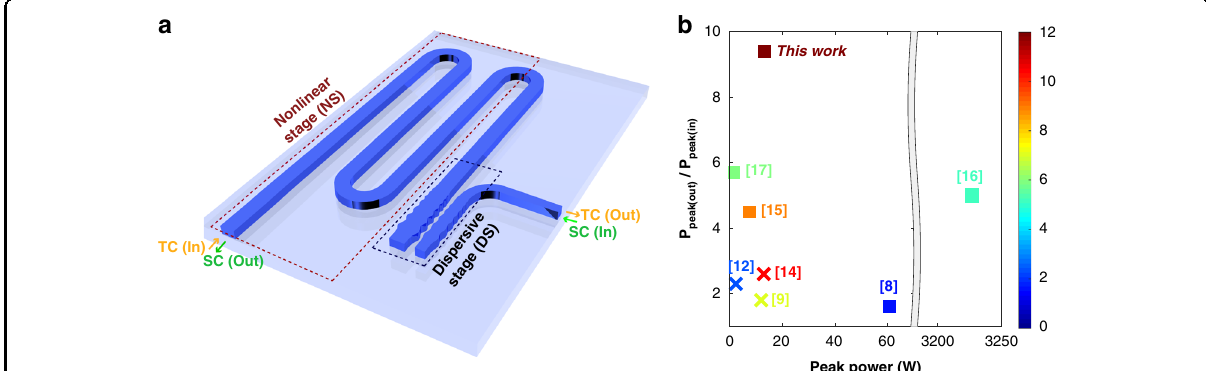
Fig. 1 Schematic of the USRN compressor system and comparison with other CMOS-chip based temporal compressors. a Schematic of the USRN compressor system. The system is comprised of separate nonlinear and dispersive stages. For spectral compression (SC), pulses enter the dispersive stage (DS) fi rst before the nonlinear stage (NS), and for temporal compression (TC), pulses enter NS fi rst before DS. b Comparison plot for various CMOS-chip based temporal compressors, comparing P peak(out) / P peak(in) , compression factors and peak powers used for compression. Squares ( ■ ) denote TPA-free compression, crosses (×) denote that TPA is present, and the color bar denotes the temporal compression factor. For refs. 8,12,16,17 , P P peak(out) / peak(in) was not reported. For these, we have denoted the values of P P peak(out) / peak(in) will be lower than compression factor because of the presence of pulse pedestals. In systems with TPA ( × ), this metric will be further reduced by nonlinear